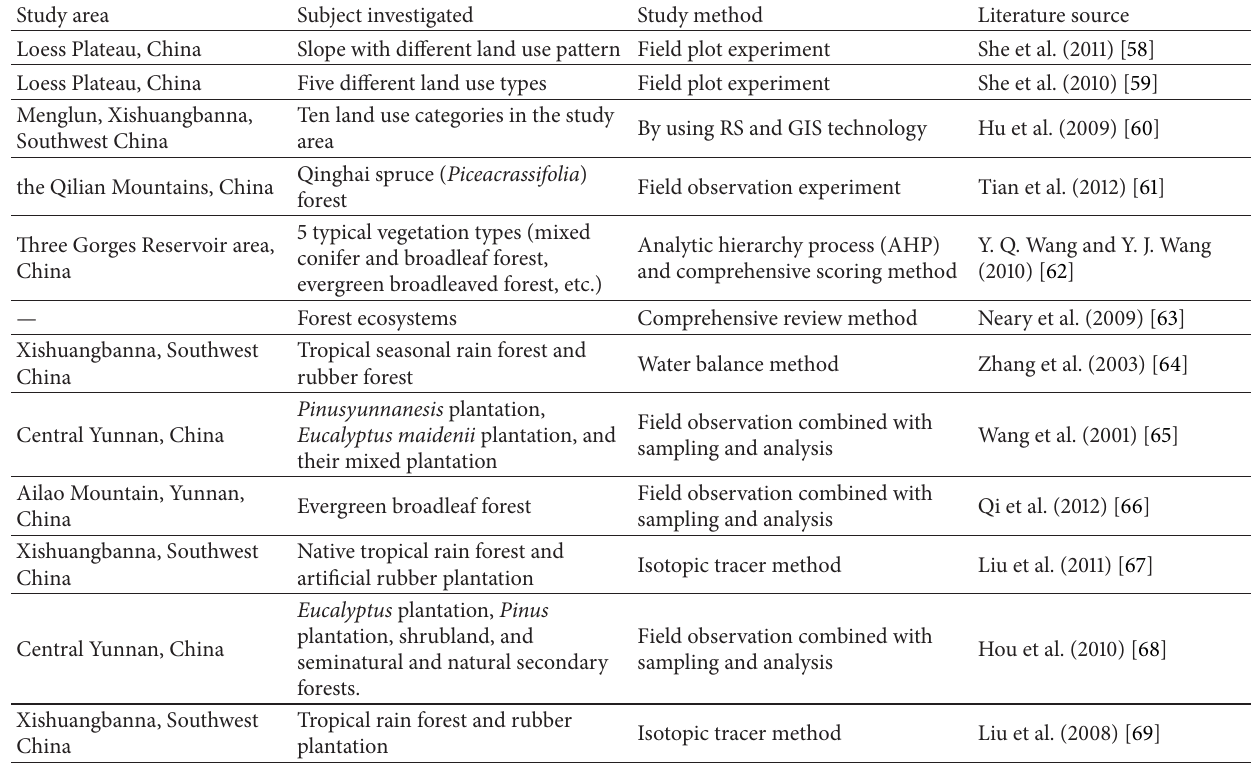
Table 3: Typical cases of study on hydrological regulation effect of